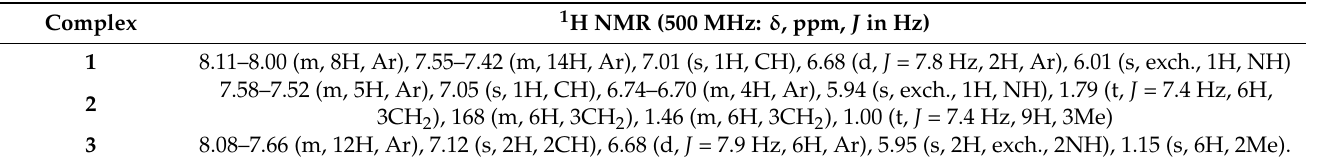
Table 3. 1 H-NMR spectral data of 1 – 3 .